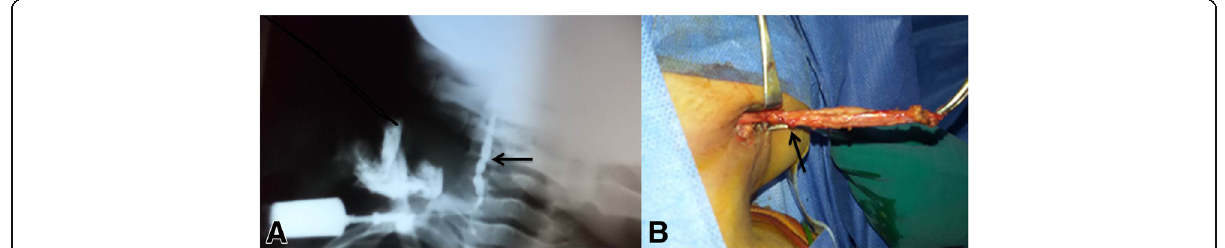
Fig. 3 Thyroglossal fistula. a Fistulography; the image illustrates a tract in the right side of the neck (arrow). b A photograph of the fistulous tract on surgery